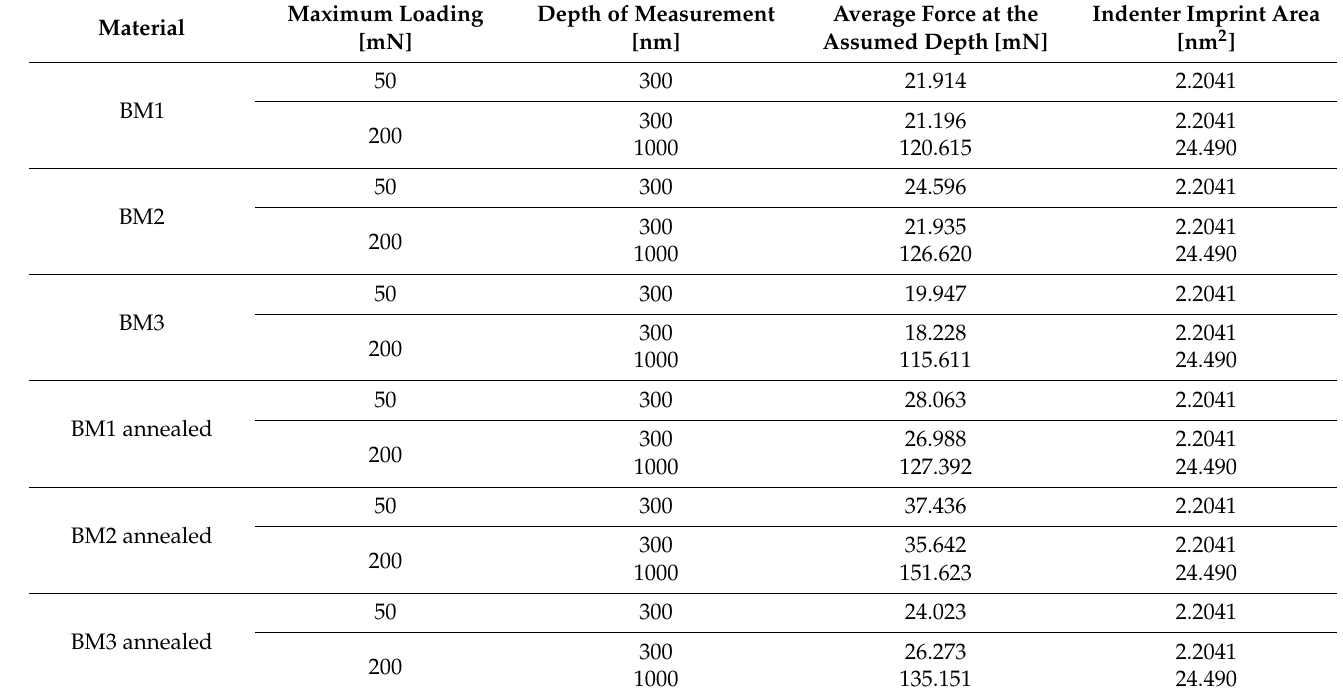
Table 11. Values adopted for the calculation of residual stresses.